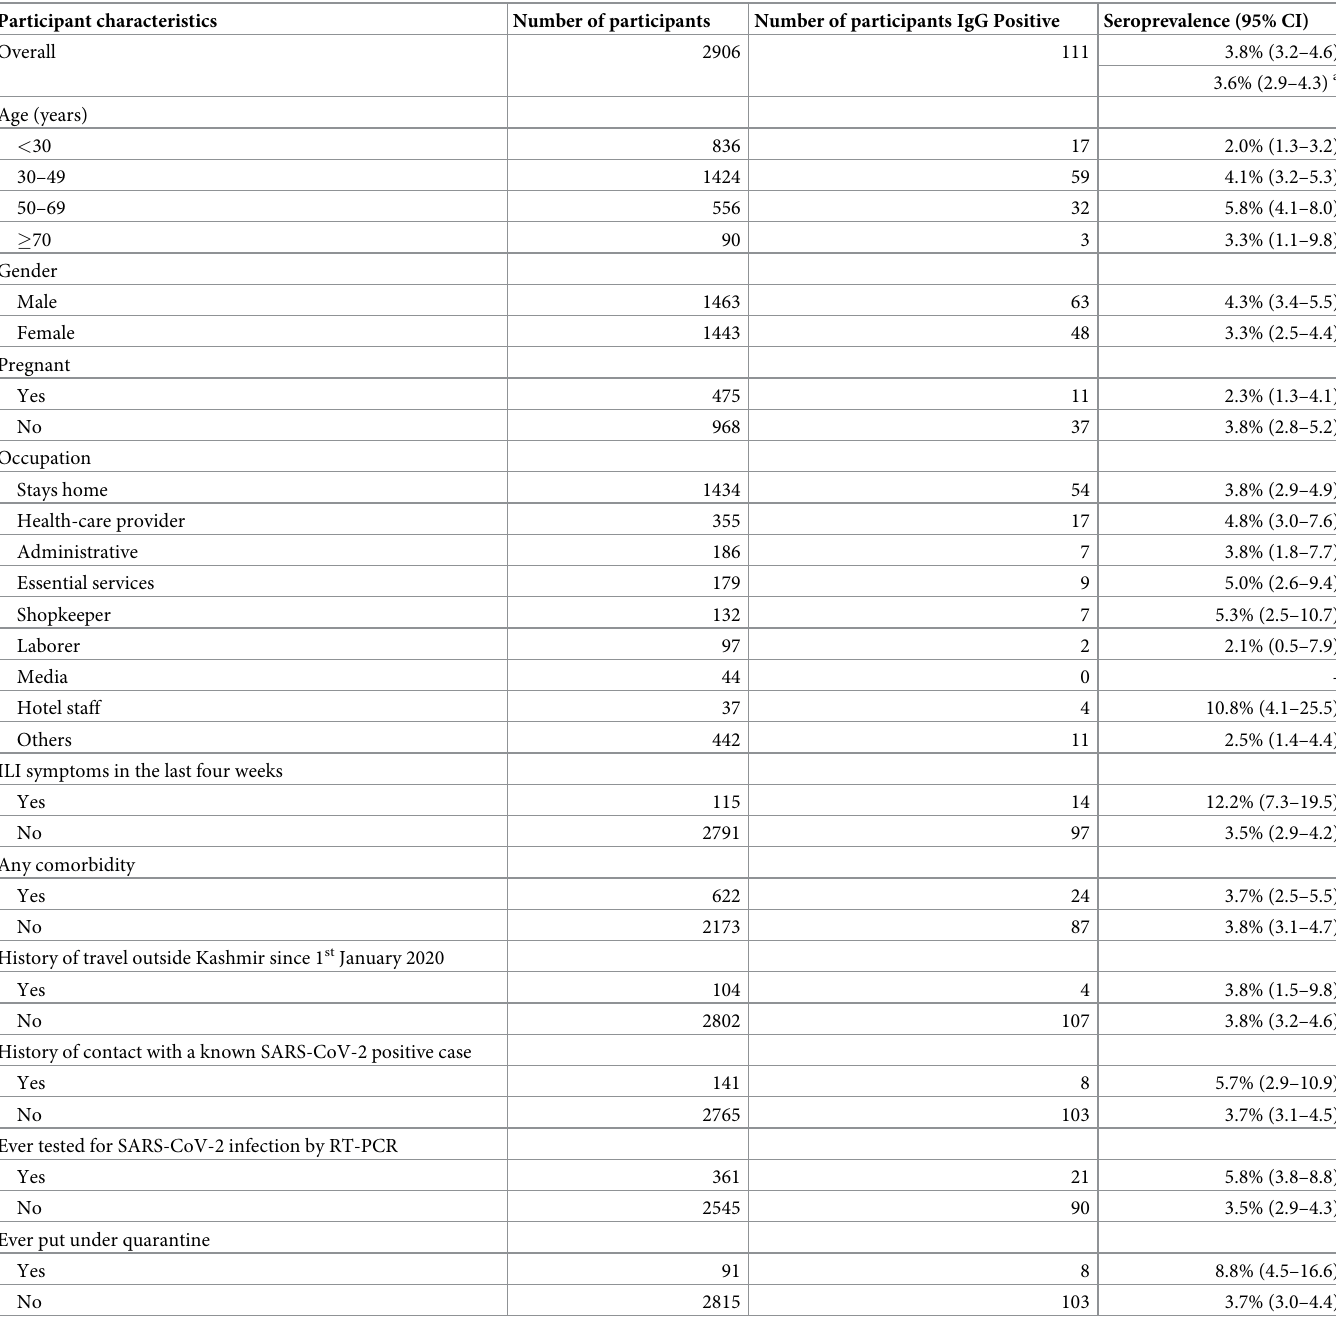
Table 1. Seroprevalence of SARS-CoV-specific IgG antibodies by participant